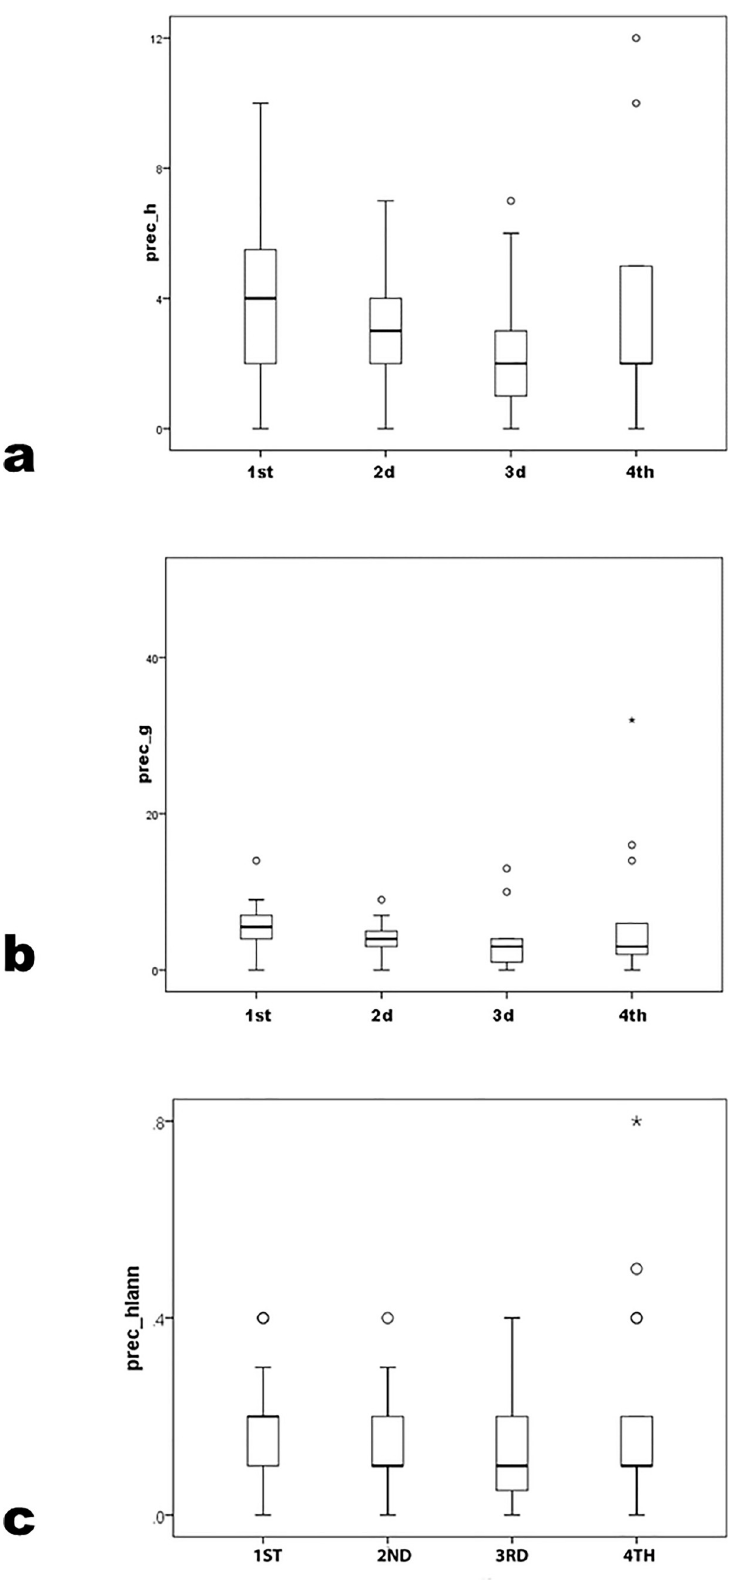
Fig 10. prec_ h , prec_ g and prec_ hIann by NRC-rank quartiles. https://doi.org/10.1371/journal.pone.0259038.g010 PLOS ONE | https://doi.org/10.1371/journal.pone.0259038 January 31,